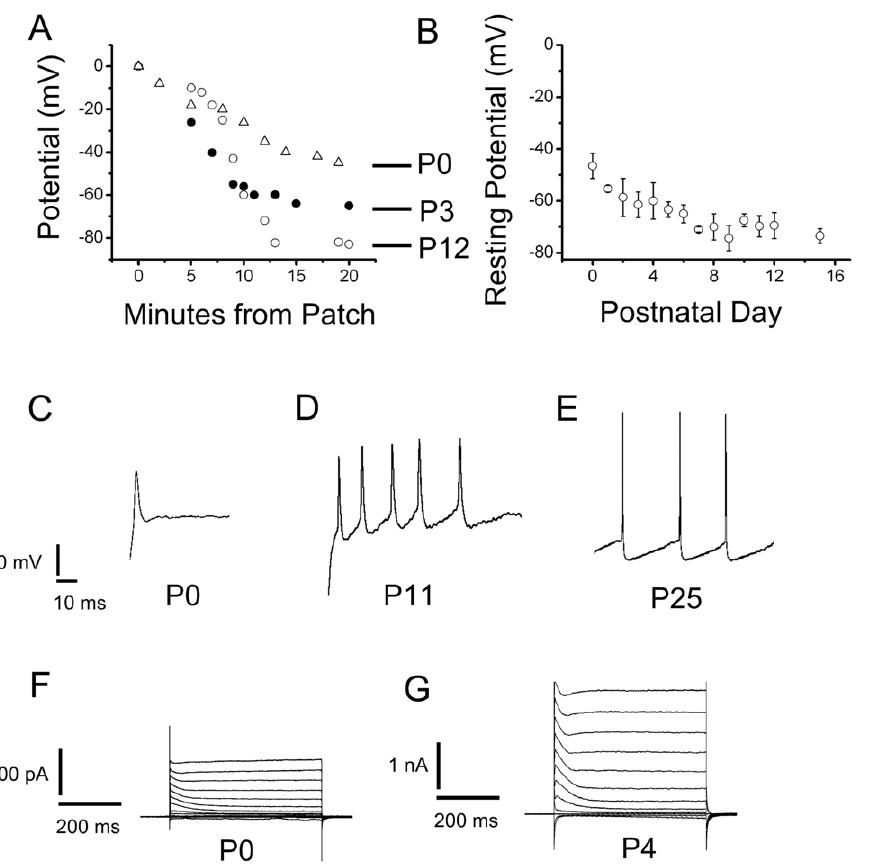
Figure 2. Excitability Changes in SN DA neurons during development. (A) Resting potential measurements for three SN DA neurons as a function of time. After obtaining a cell-attached patch, we waited to gain access as the gramicidin diffused from the back of the pipette onto the tip, measuring the voltage drop necessary to maintain a zero current, in the search mode. The resting potential equilibrated slowly as gramicidin was incorporated into the patch. Only recordings that developed over the course of several minutes and were stable after reaching equilibrium were used. Open triangles, neuron at P0. Closed circle, neuron at P3. Open circles, neuron at P12. (B) Resting potentials measured with the method illustrated in A, are plotted as a function of postnatal day of development. (C),(D) & (E) Electrical activity of SN DA neurons in response to depolarizing current pulses. Neurons in the fast-current clamp mode, were depolarized by current injections. P0 to P5 neurons never displayed spontaneous firing. The P0 neuron shown here was depolarized to 2 20 mV, from a resting potential of 2 40 mV. The P11 neuron was depolarized to 2 40 mV from a resting voltage of 2 60 mV. The P25 could fire a continuous train of action potentials from resting potential of 2 60 mV. Small current injections were performed to adjust the resting voltage. Small current injections were performed from resting voltages (Notice difference between P0 and P11). This was on purpose to avoid large current injections that could distort the recording. However, even when depolarized from 2 60 mV, P0 and P1 neurons never fired action potential continuously, but rather the small wide action potentials shown here. (F) Typical voltage clamp current in responses to voltage pulses with 20 mV increments from a holding potential of 2 80 mV to test pulses from 2 120 to 100 mV with 20 mV increments. Raw traces shown, no leak subtraction. P0 neuron shows the typical outward current with an inactivating I A current and a non-inactivating current. Small I h and inward rectifier currents were also observed at hyperpolarized potentials less than 2 80 mV. (G) A P4 neuron with a larger outward current, in response to the same voltage protocol as in F. This neuron also had larger I h and inward rectifier currents, not analyzed